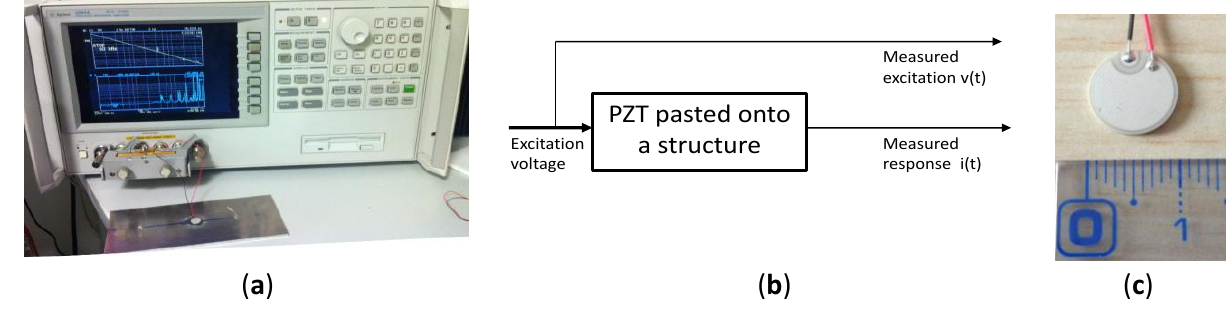
Figure 2. Experimental measurement results recorded using the Agilent 4294A for the same specimen (baseline, and after the introduction of one crack and two cracks). The specimen used for the test is made from an Al2024 certified aeronautics